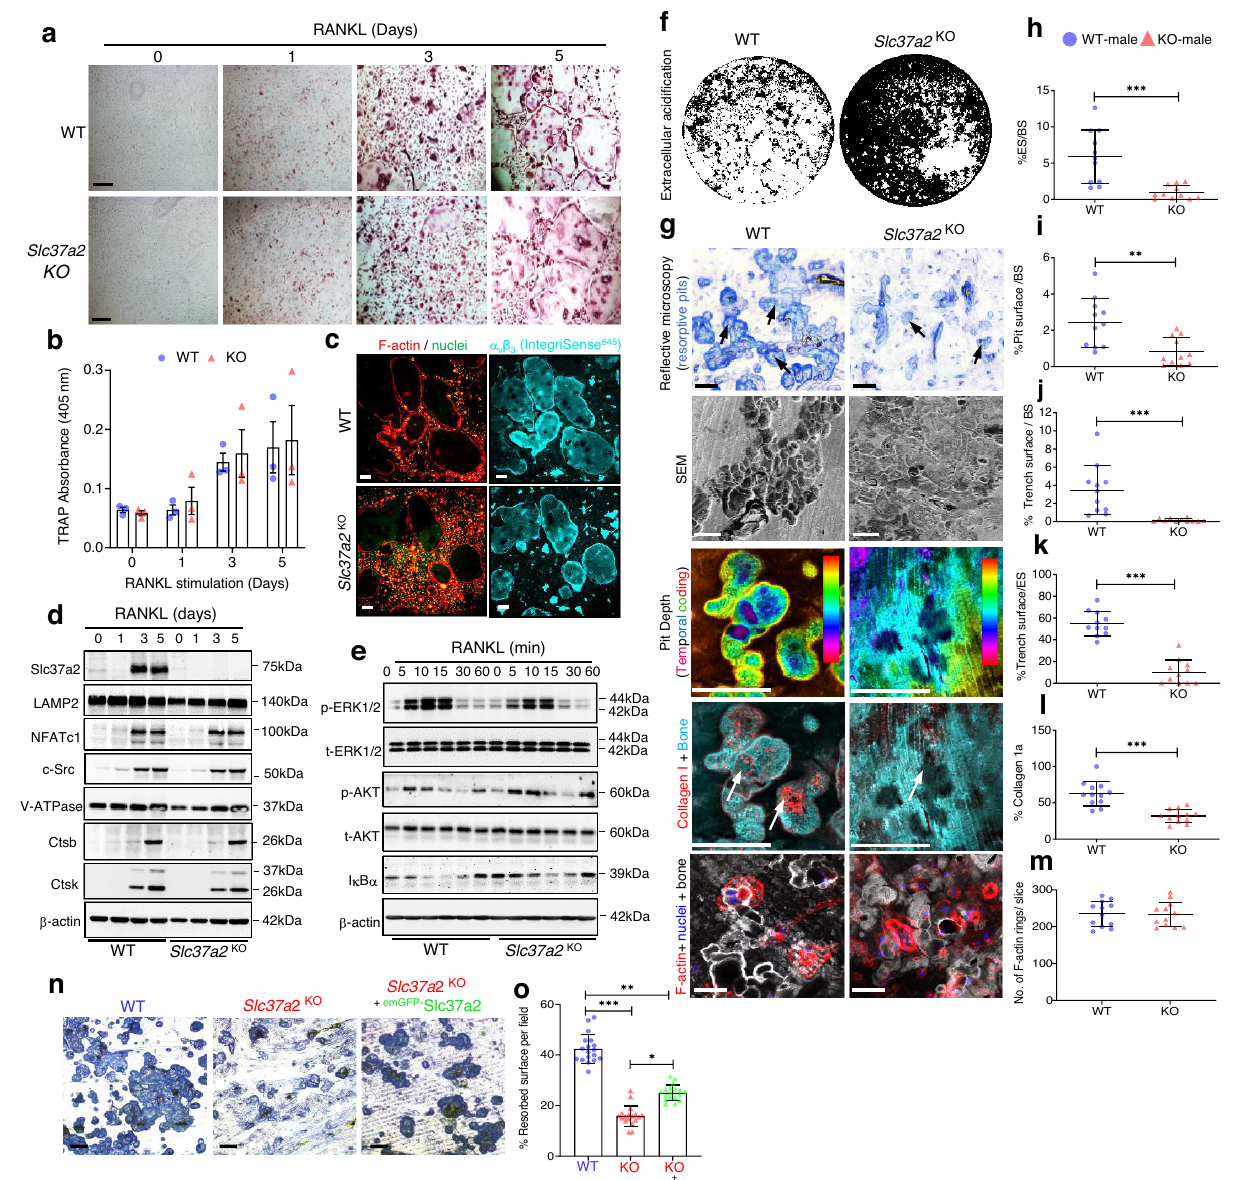
Fig. 8 | Slc37a2 deletion impairs bone resorption but does not alter osteoclast differentiation, spreading, or RANKL-signaling cascades. a and b WT and Slc37a2 KO BMM-derived osteoclasts were TRAP stained ( a ), and TRAP activity measured (405nm) ( b ) ( n =3). Bar, 50 µ m. c Representative images of WT and Slc37a2 KO osteoclasts immunostainedfor F-actin, α v β 3 (IntegriSense 645 ) and nuclei. Bar 50 µ m. d Expression of osteoclast and SL markers during RANKL-induced dif- ferentiation of WT and Slc37a2 KO BMMs by immunoblotting using indicated anti- bodies ( n =3). e RANKL-signaling in WT and Slc37a2 KO BMMs. Immunoblotting of the levels and phosphorylation states of ERK1/2, AKT, and I κ B α in response to RANKL( n =3). f RepresentativeVonKossastainingofWTand Slc37a2 KO osteoclasts on mineralized substrates ( n =3). g – m Representative images of in vitro bone resorption assays of WT and Slc37a2 KO osteoclasts using re fl ective microscopy, SEM, and confocal microscopy with quanti fi cation of the percentage of eroded surface( h , n =11bonediscsfrom3experiments; P =0.0004),pitarea( i , n =11bone discs from 3 experiments; P =0.0029), trench surface per bone slice ( j , n =11 bone